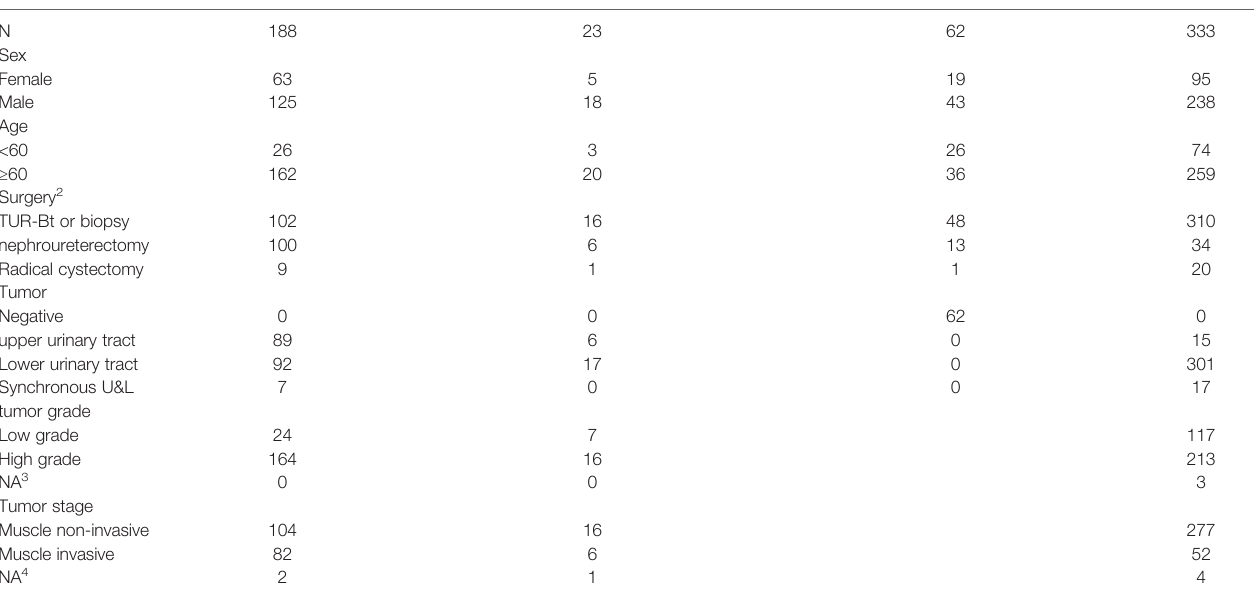
TABLE 2 | Surgical